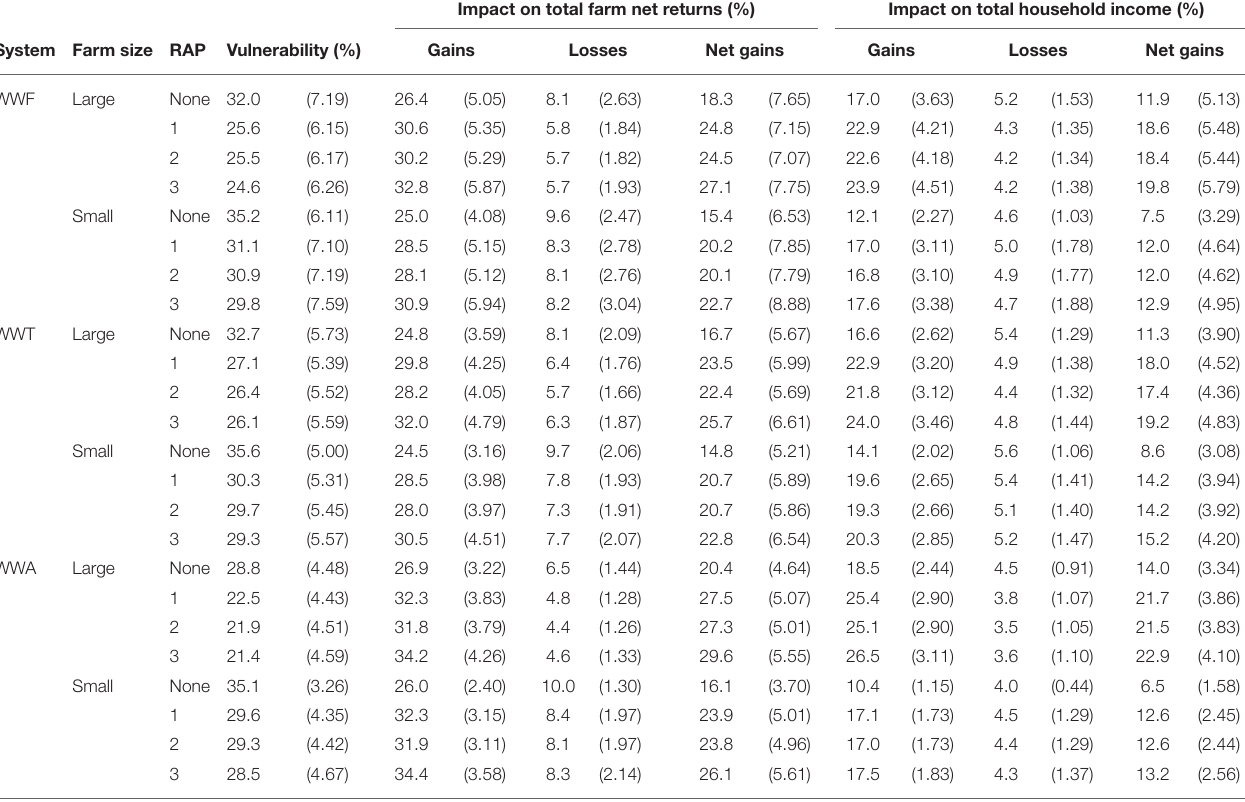
TABLE 5 | Climate change impacts in 2050 without adaptation, REACCH study